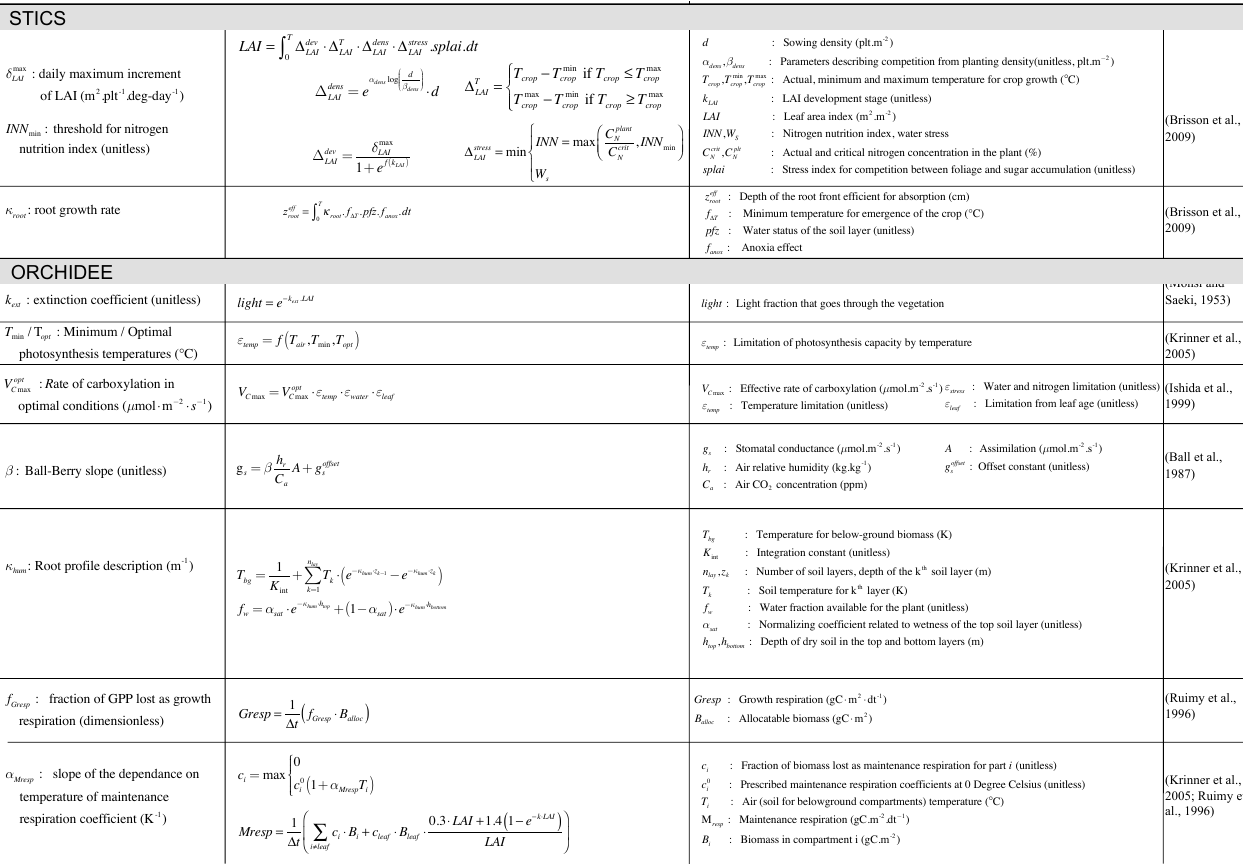
radar plot but only those parameters that pertain to the 10 top- ranked parameters at least at one site. The maximum number of 10 parameters was fixed based on examination of Morris indices µ ∗ and σ at individual sites that only revealed 3